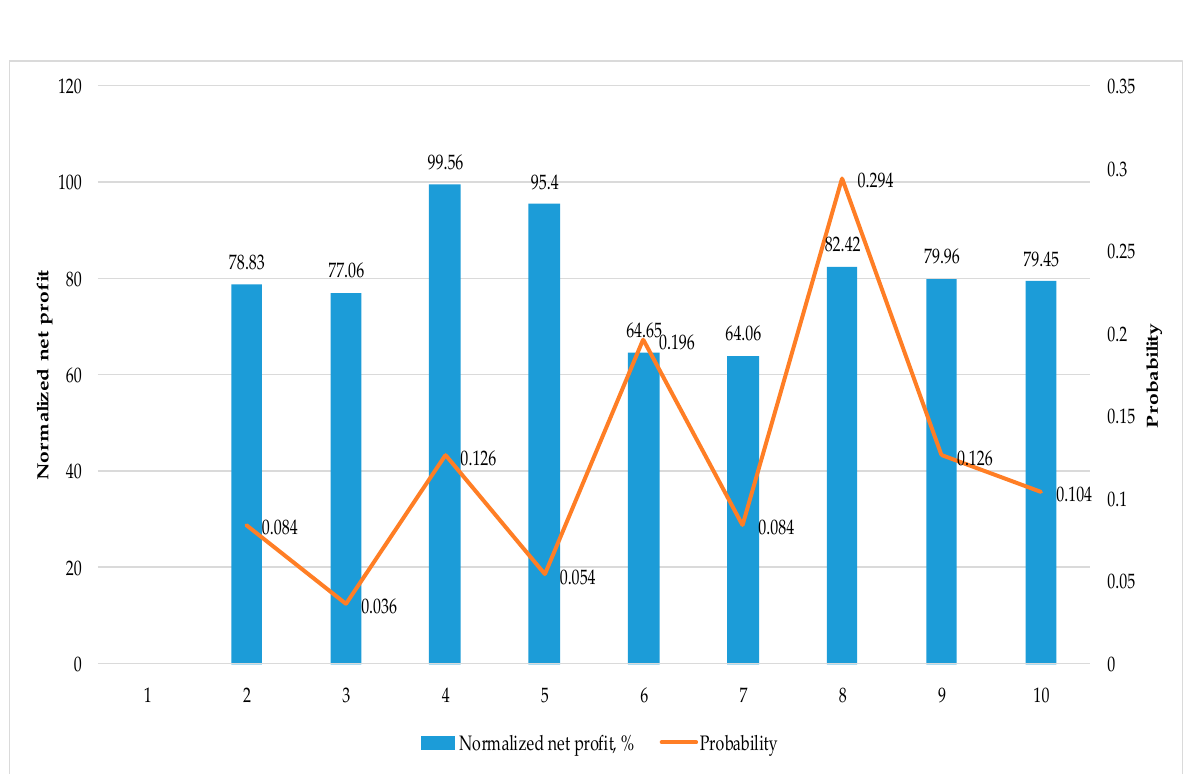
Figure 4. Efficiency indicators of RES investment projects and probability by indicators “Normalized net profit, %” and “Probability”.